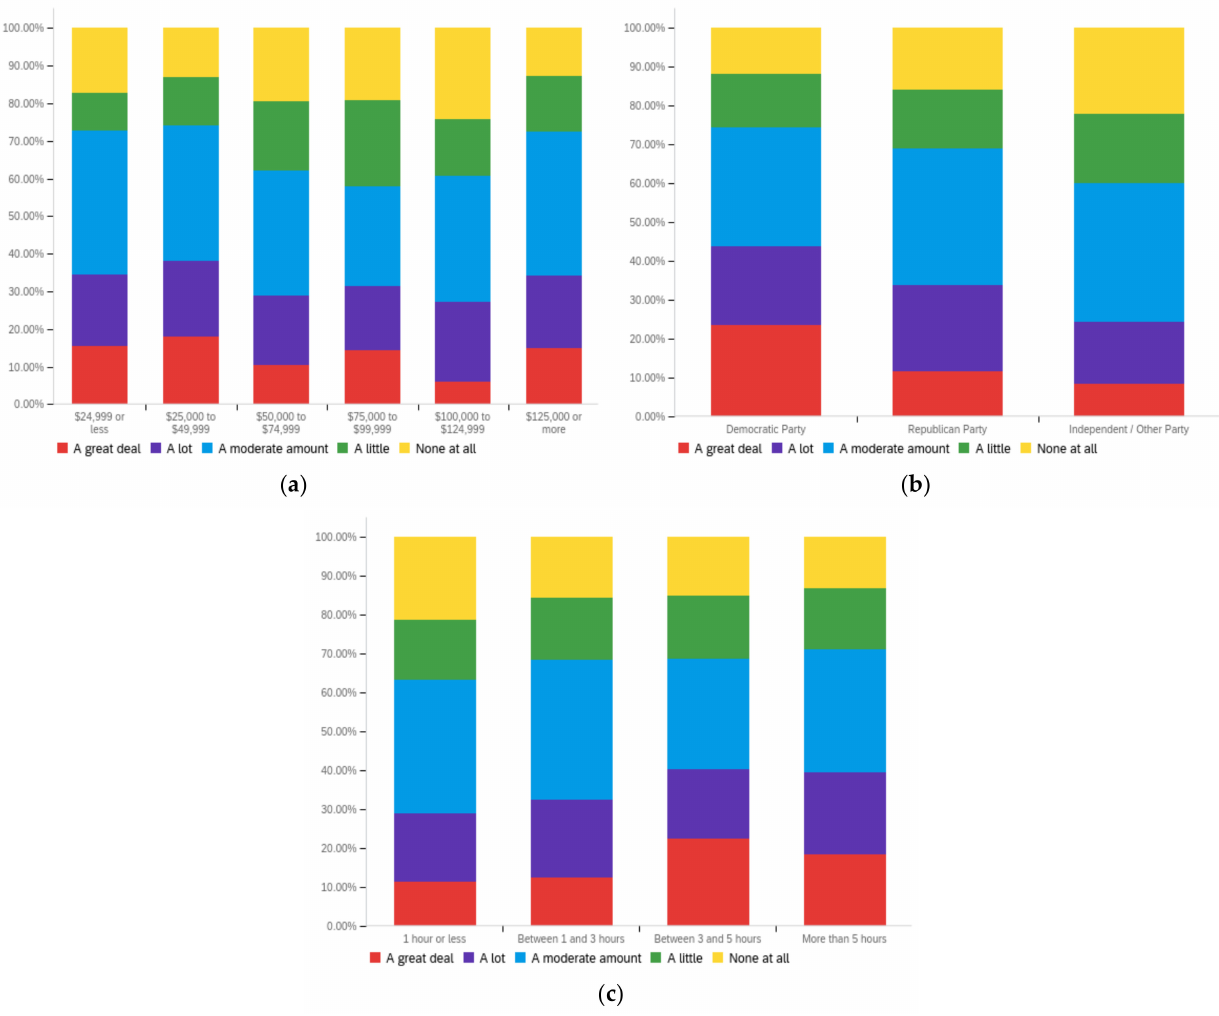
Figure A33. Article controversy level—ideal perception impact by: ( a ) income level (top left), ( b ) political affiliation (top right) and ( c ) online usage